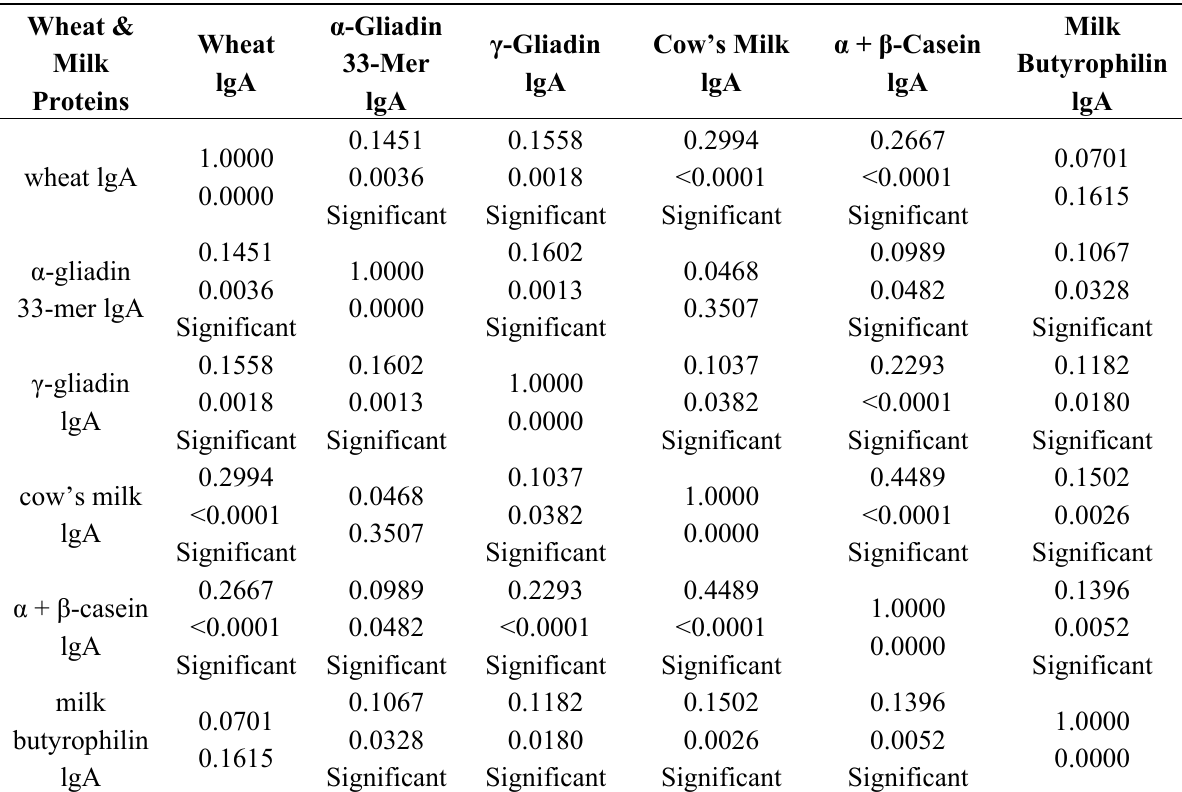
Table 5. Results of the simple linear regression between each pair of lgA isotype of the antigens. The first number in each cell presents corresponding Pearson’s correlation coefficient and the second number presents its p -value. Small p -value (less than 0.05) indicates statistical significance. Note that R 2 values of these regressions are the squares of the Pearson’s correlation coefficients.